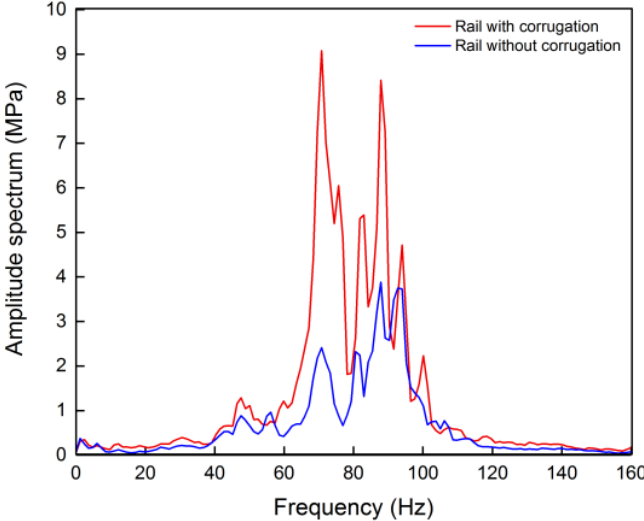
Figure 18. The amplitude spectrum comparison of the dynamic stress of the frame with and without the rail corrugation.